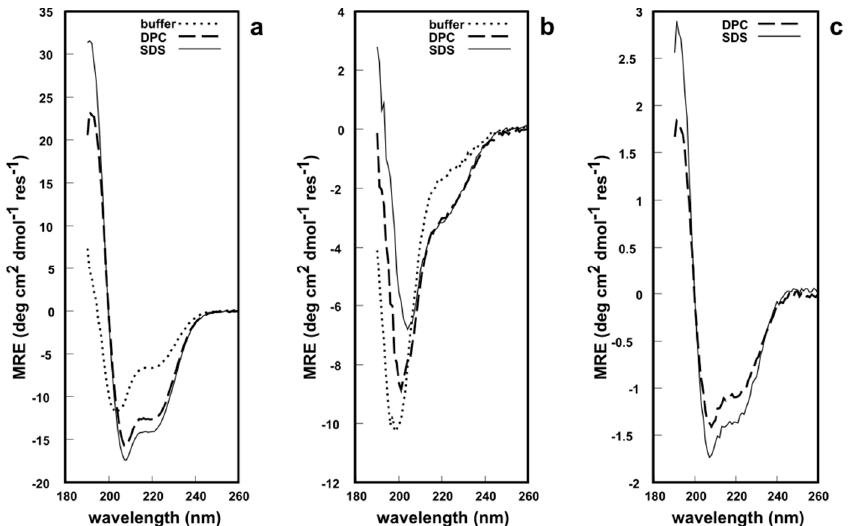
Figure 4. Circular dichroism (CD) spectroscopy of the: ( a ) EqtII(1–46) fragment; ( b ) EqtII(47–85) A47C fragment; ( c ) EqtII(1–85) fragment (as the 4-mercaptophenylacetic acid (MPAA) adduct). ~40 μ M peptide/protein in buffer, 15 mM dodecylphosphocholine (DPC) or sodium dodecyl sulfate (SDS) micelles, pH 7.2, 25 °C.